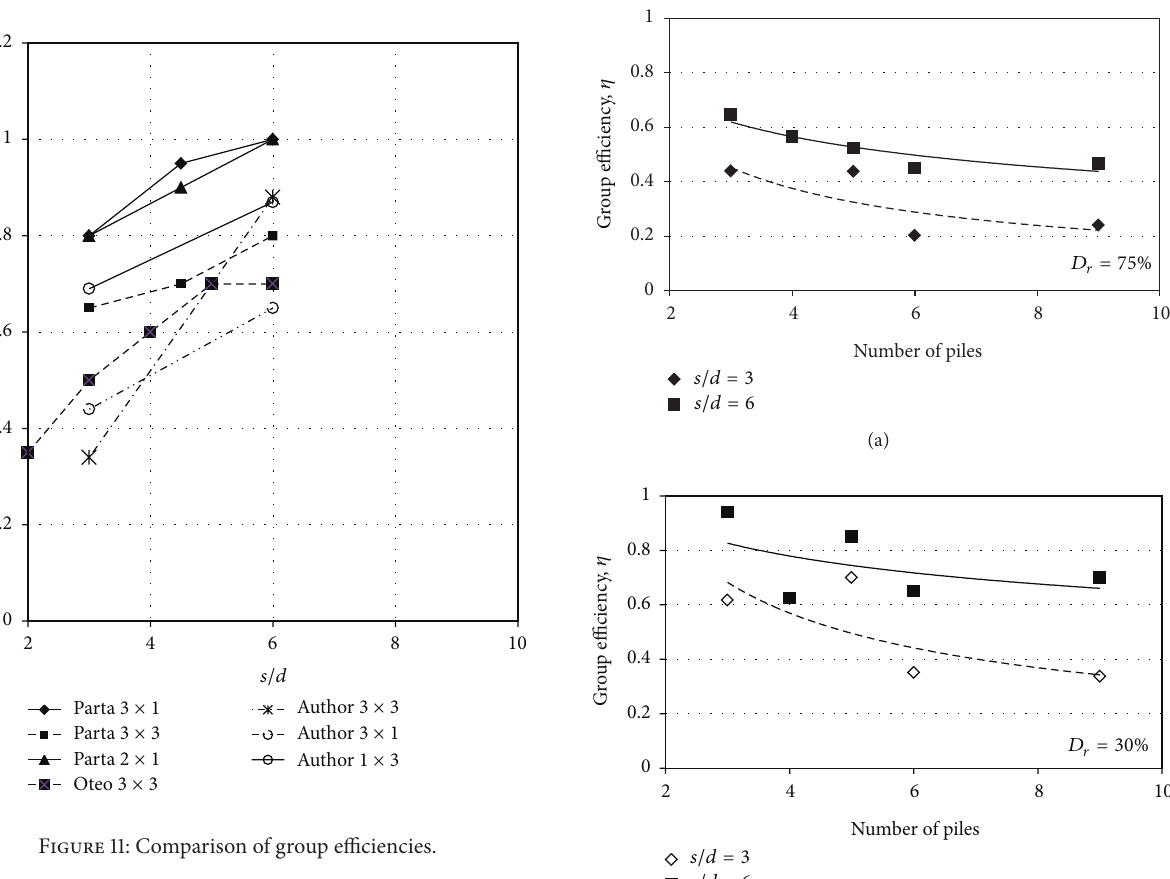
Figure 11: Comparison of group efficiencies.